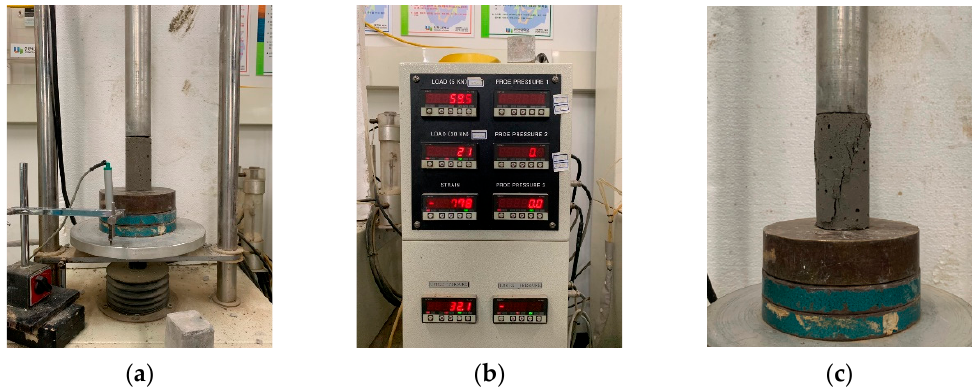
Figure 7. Procedure for unconfined compressive strength test: ( a ) specimen placement; ( b ) measurement of unconfined compressive strength; ( c ) specimen failure.